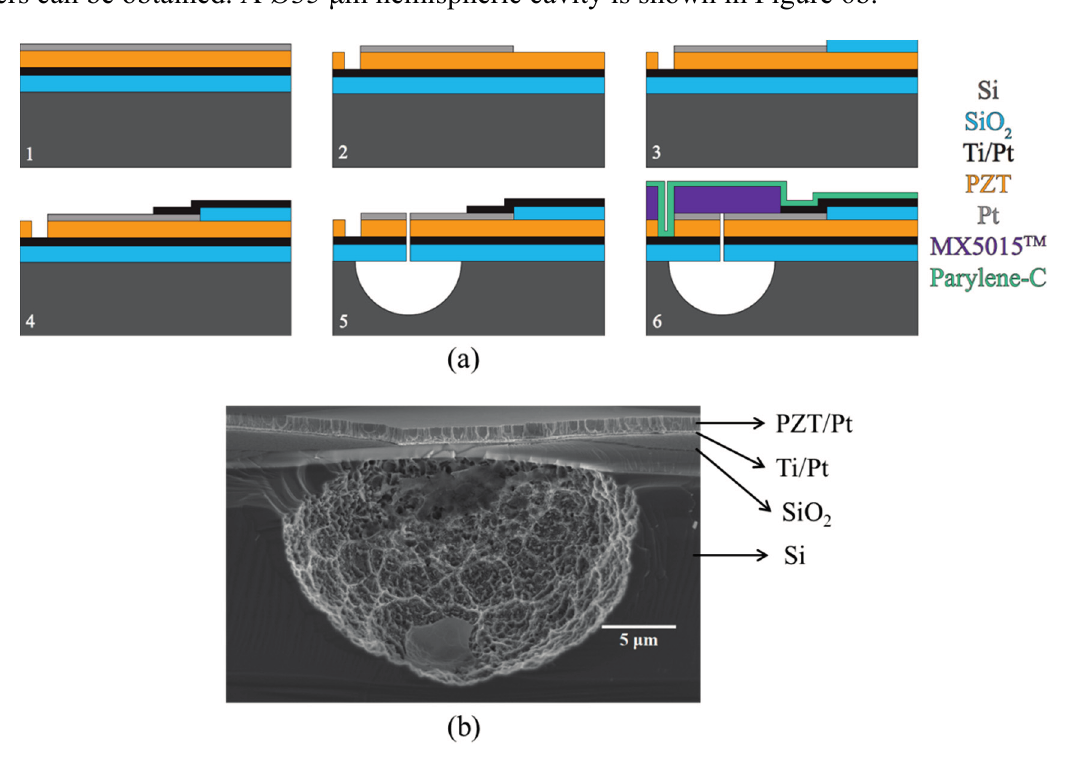
Figure 6. ( a ) Fabrication process flow of PMUTs with diaphragm defined by front-side etching; ( b ) FESEM cross-sectional image of a released